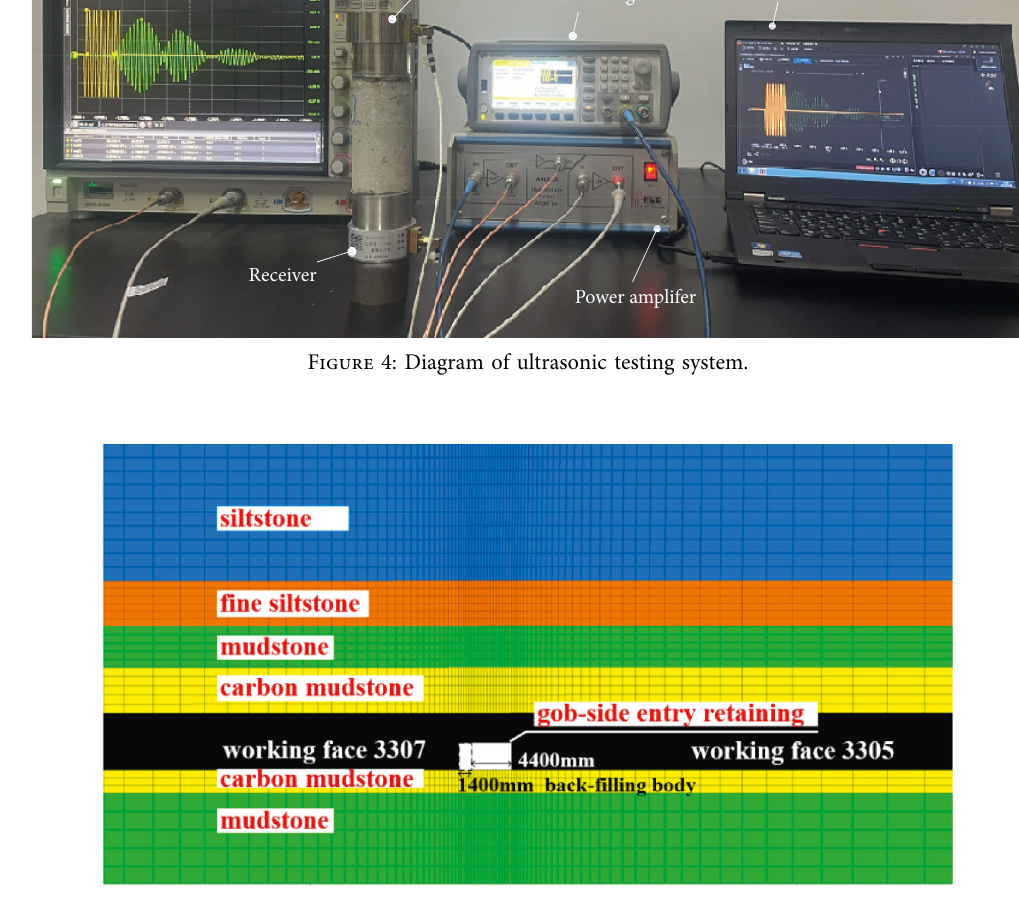
Figure 5: Numerical calculation model.